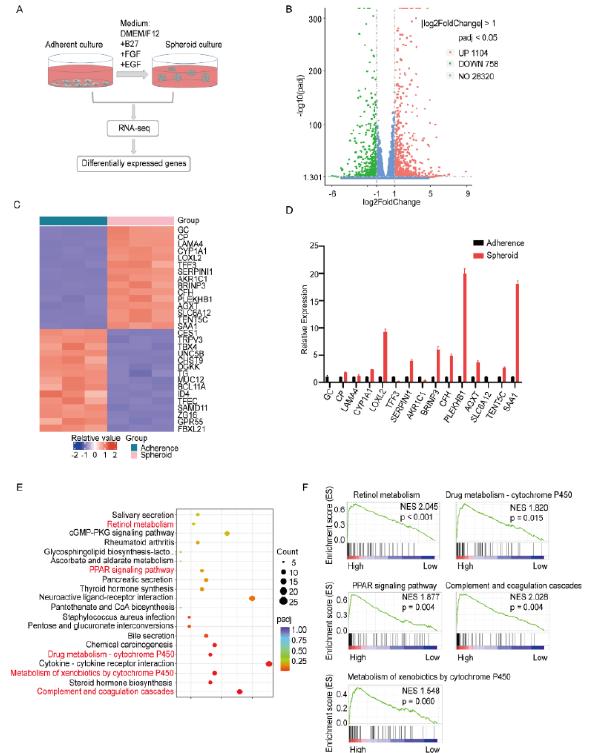
Figure 1. Identification of differentially expressed genes (DEGs) between spheroid and adherent cells: ( A ) A schematic outline for the identification of differential genes in spheroid and parental cells. Huh7 cells were plated on a serum-free medium in ultra-low-attachment dishes (Corning). The spheroids and adherent parental cells were harvested and subjected to transcriptome sequencing; ( B ) a volcano plot showing genes differentially expressed in the adherent and spheroid cell groups. The red dots represent upregulated genes (1104), the green dots represent downregulated genes (756), and the blue dots represent non-DEGs (28320); ( C ) a heatmap showing the top 15 genes with the most upregulation and downregulation; ( D ) quantitative real-time polymerase chain reaction of the top 15 genes in the adherent cells and spheroid cells; ( E ) bubble plot of the Kyoto Encyclopedia of Genes and Genomes (KEGG) enrichment analysis of upregulated DEGs. The ordinate represents the top-20 upregulated pathways, the color of the bubble represents the size of the p value, and the size of the bubble represents the number of enriched differential genes; ( F ) gene set enrichment analysis of KEGG signaling pathways in the high alanine − glyoxylate aminotransferase expression group of the Cancer Genome Atlas – Liver Hepatocellular Carcinoma cohort.